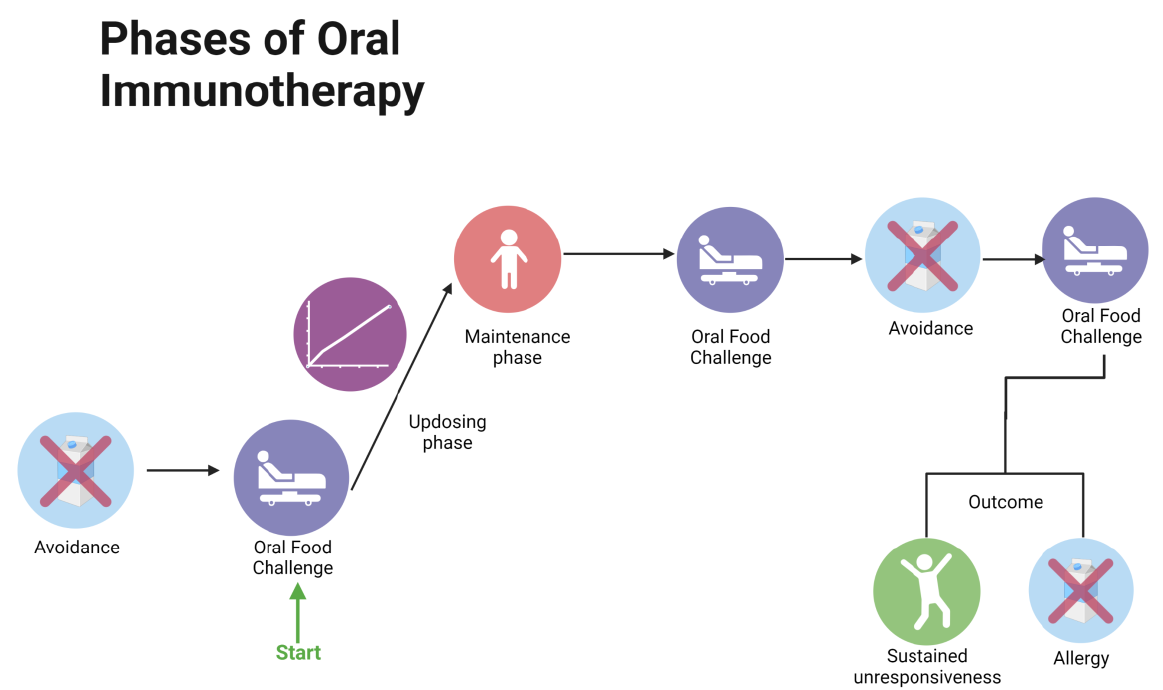
Figure 5. Phases of OIT.